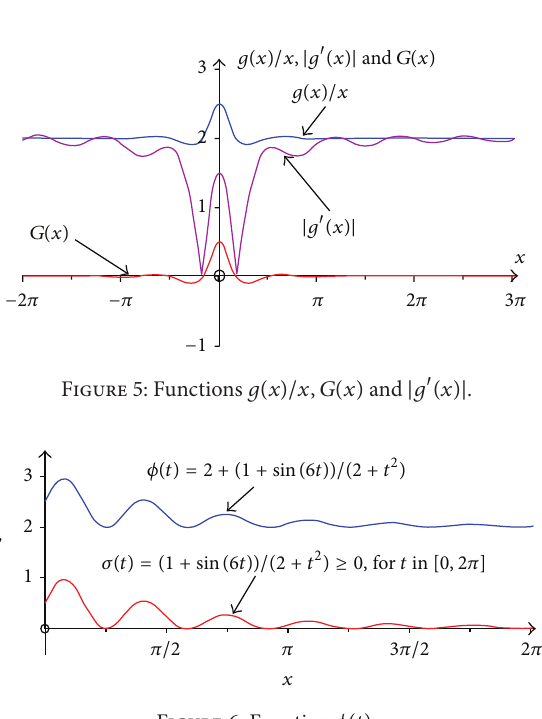
Figure 6: Function 𝜙(𝑡)